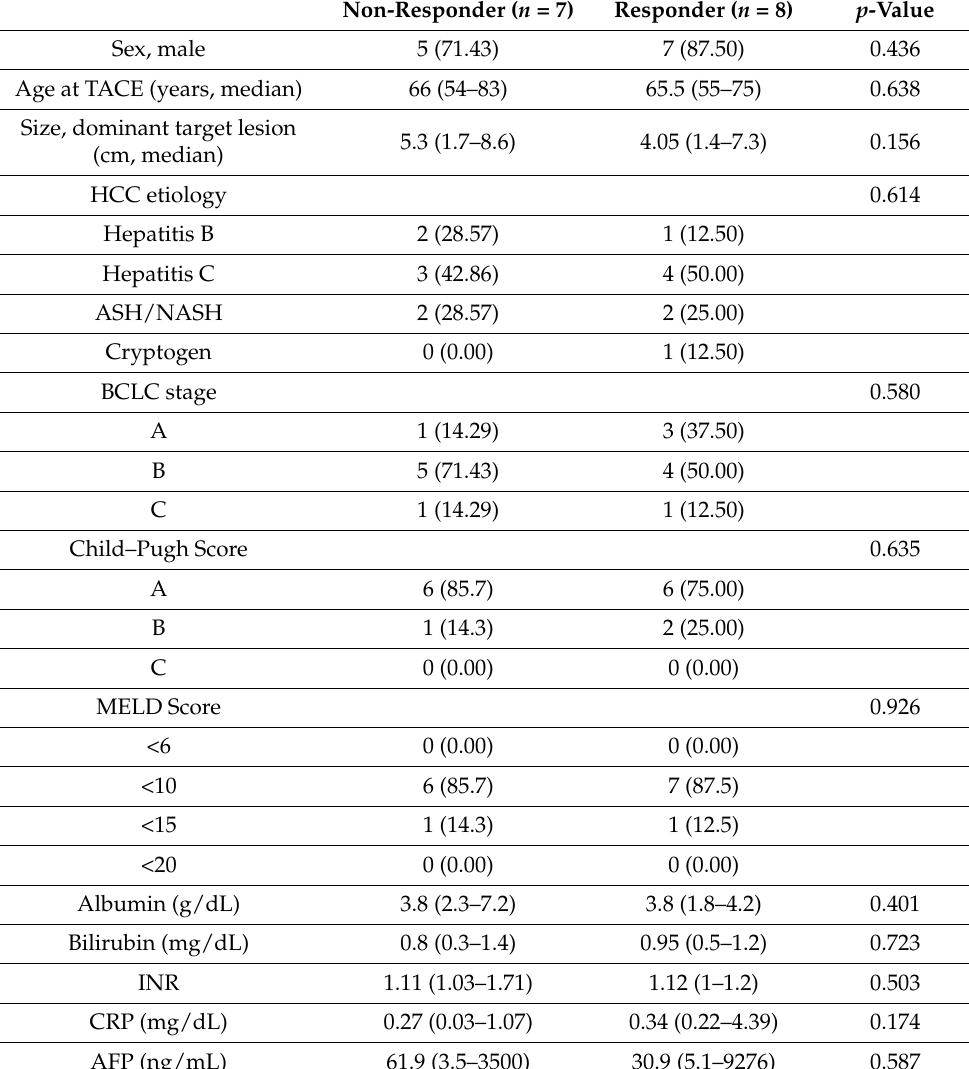
Table 1. Clinical and epidemiological